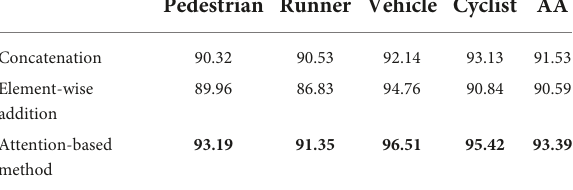
TABLE 6 Experimental results of different combination